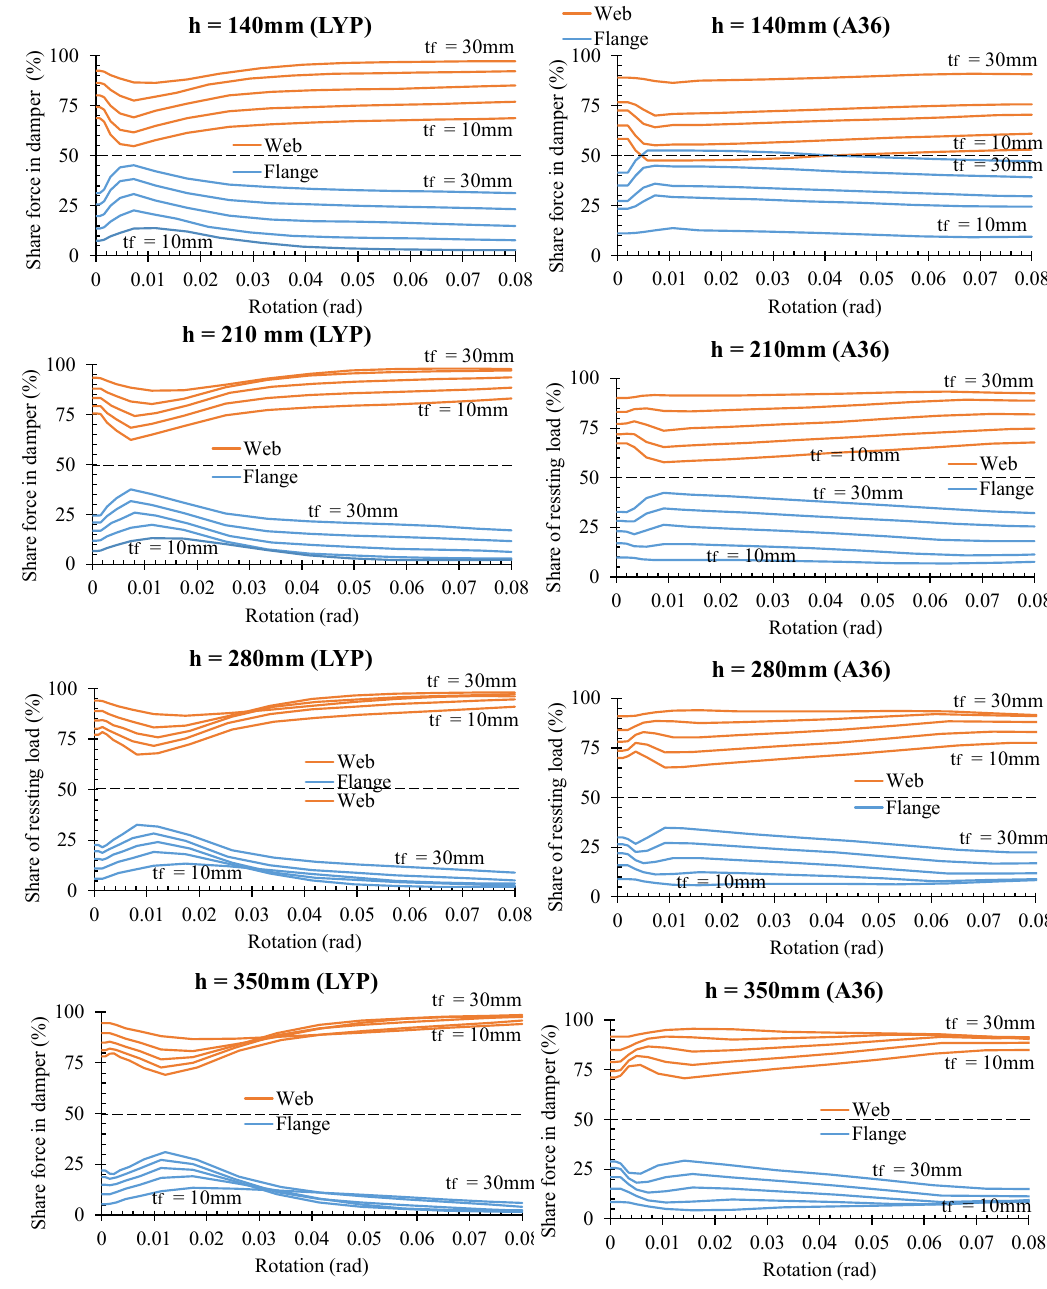
Figure 10. Share of load absorbed by the shear link flange and web for FE models (h-t f - ρ - ψ ). Accordingly, by increasing the h to 350 mm (b/h > 1), the flange absorbs 5.42% to 21.86% (by increasing the t f from 10 mm to 30 mm) at the beginning of loading and 6.64% to 6.45% at the end of loading for LYP dampers. For A36 dampers, the flange absorbs 15.1% to 28.9% (by increasing the t f from 10 mm to 30 mm) at the beginning of loading and 8.86% to 15.01% at the end of